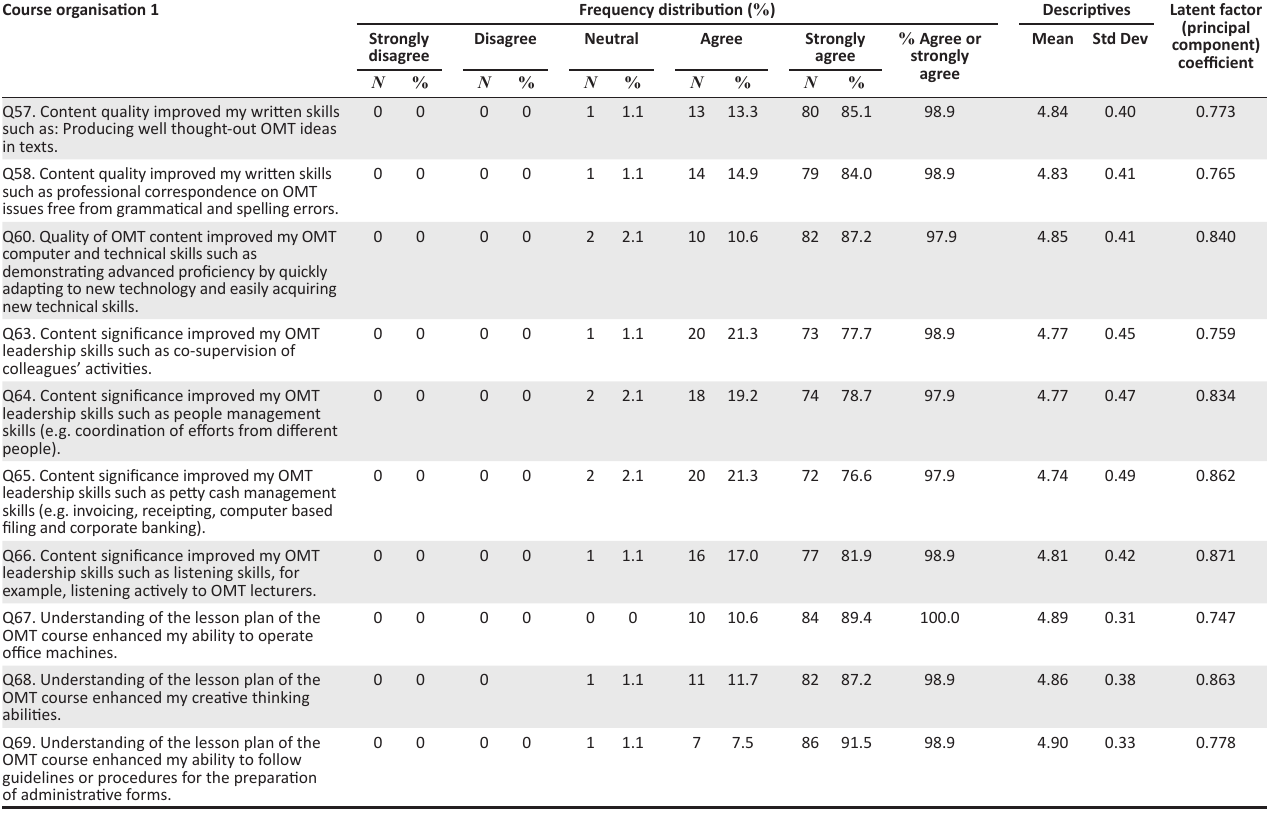
TABLE 8: Effects of course organisation 1. Course organisation